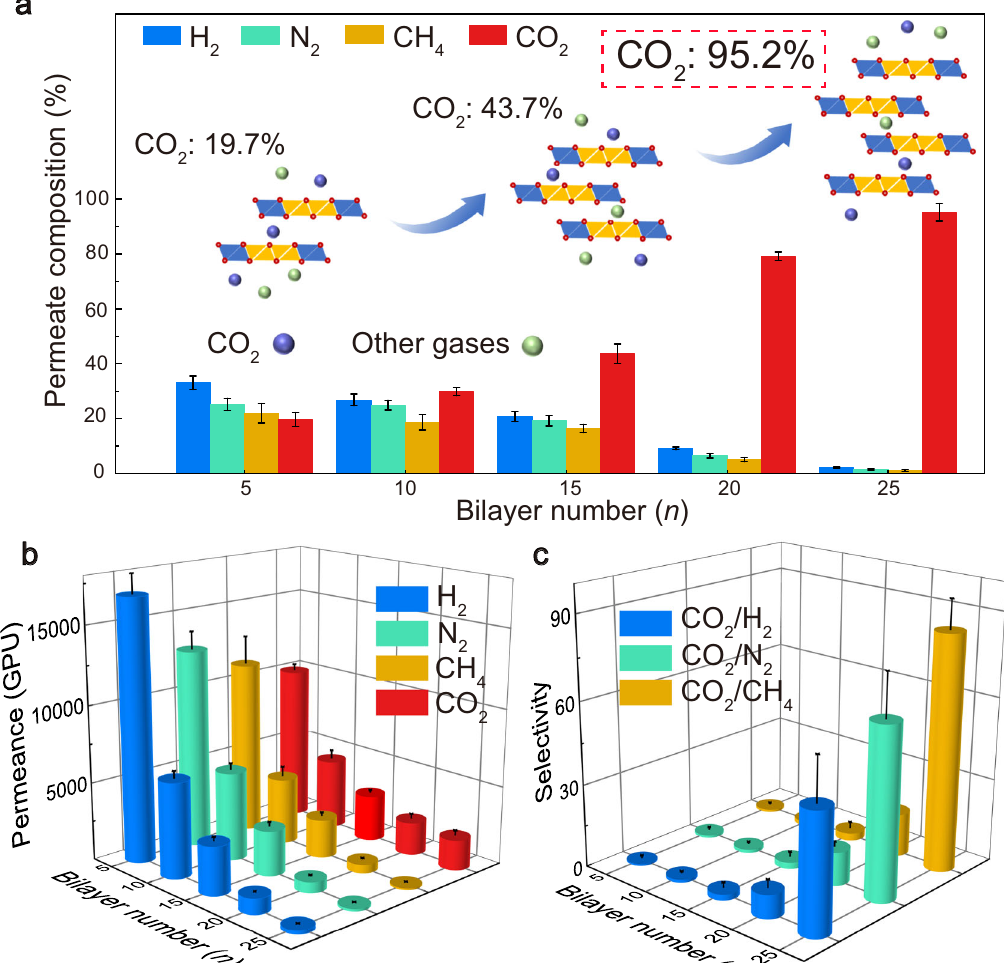
Fig. 5 Mixed gas separation performance of (LDH/FAS) n -PDMS membranes. a The H 2 , CO 2 , N 2 , CH 4 contents in the fi ltered gas for (LDH/FAS) n -PDMS membranes under mixed gas feed conditions. b The H 2 , CO 2 , N 2 , CH 4 transmission rates and c the CO 2 /H 2 , CO 2 /N 2 , CO 2 /CH 4 selectivity for (LDH/